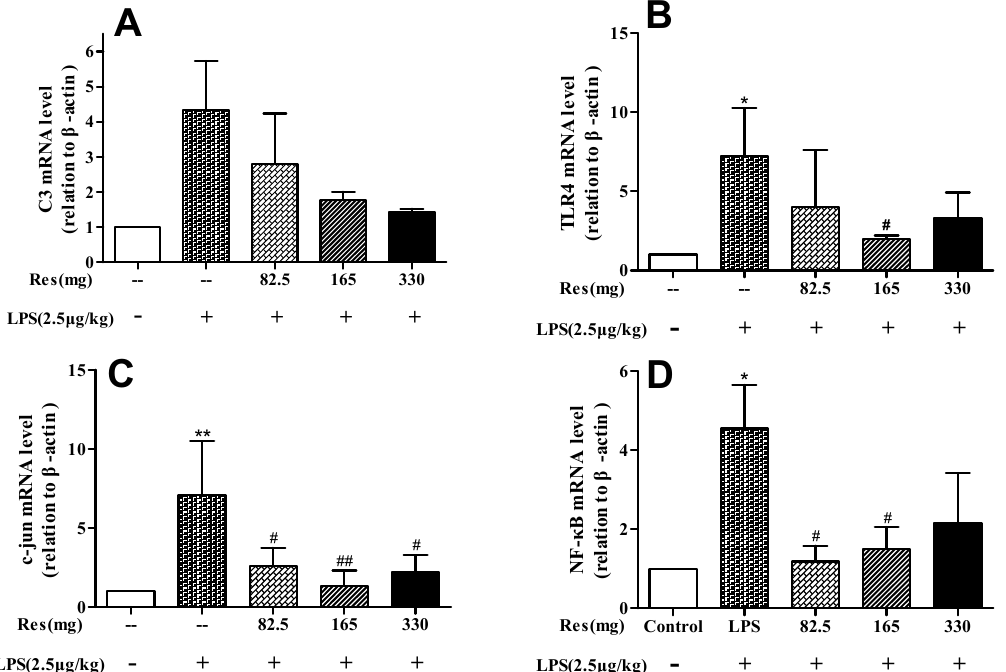
Figure 5. Effect of resveratrol on expression of immune gene C3 ( A ) and inflammatory markers in peripheral WBCs in LPS-challenged lambs, ( B ) TLR4 , ( C ) c-jun , and ( D ) NF- κ B . Values are normalized to control values and expressed as means ± SD. * p < 0.05, ** p < 0.01, and *** p < 0.001, compared with